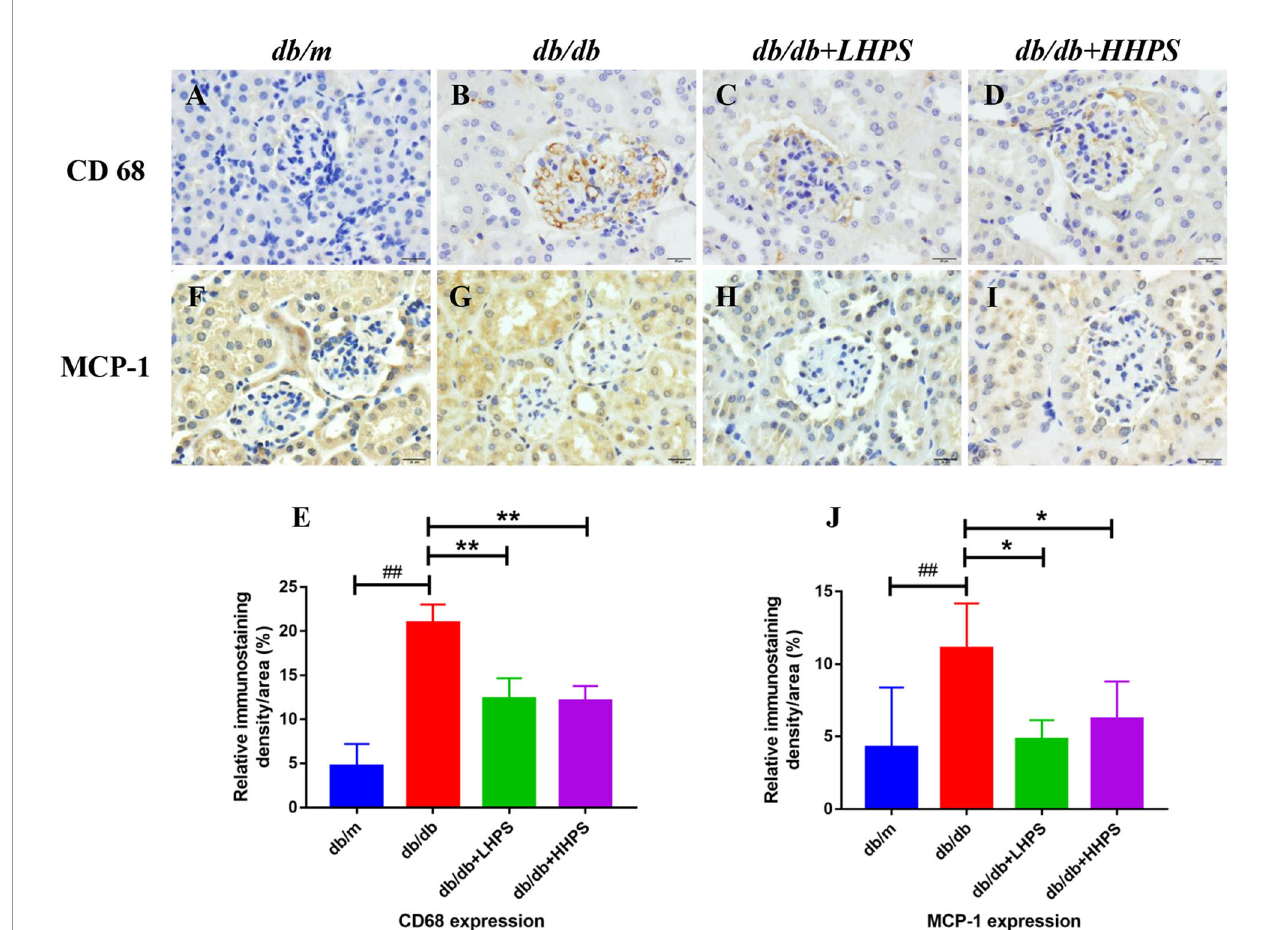
FIGURE 3 | Immunohistochemical staining of CD68 and MCP-1 in glomeruli and interstitial areas (×400, bar=20um) of the kidney in db/db mice. Immunohistochemical analysis of CD68-positive (A – D) and MCP-1-positive cells (F – I) was performed after HPS treatment. The color was developed by incubating with diaminobenzidine and counterstaining with hematoxylin (Magni fi cation x 400). Shown also is quanti fi cation of the CD68+ (E) or MCP-1+ area (J) . The data are presented as the mean ± SD (n = 5 per group, ## P < 0.01 vs db/m ; * P < 0.05 and ** P < 0.01 vs db/db , with each symbol color representing a particular